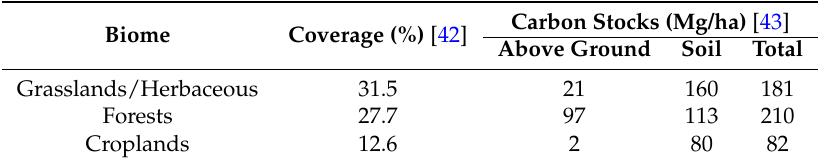
Table 1. Grasslands’, forests’ and croplands’ global coverage and carbon